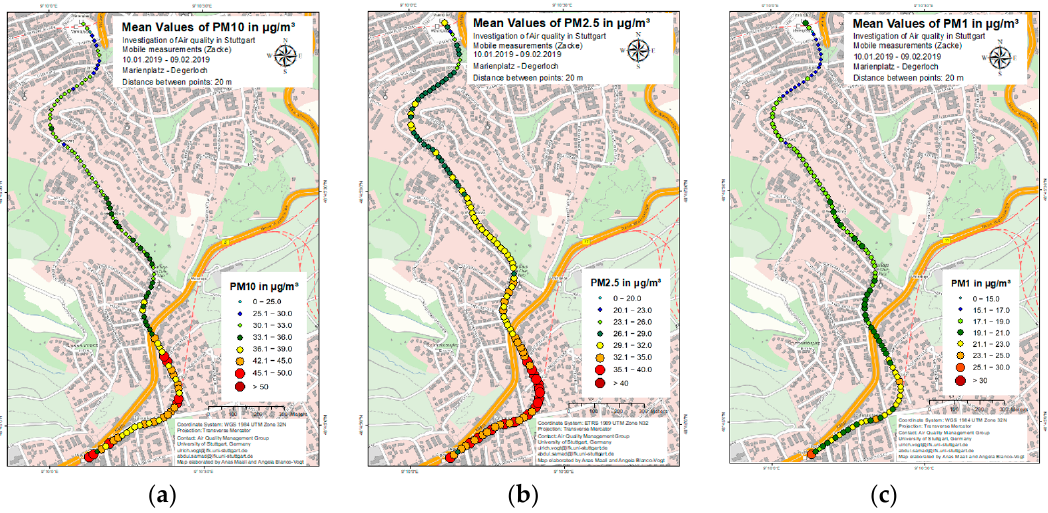
Figure 6. Average concentrations of ( a ) PM10, ( b ) PM2.5, ( c ) PM1 during the trips from Marienplatz to Degerloch for the period between 10.01.2019 to 09.02.2019.